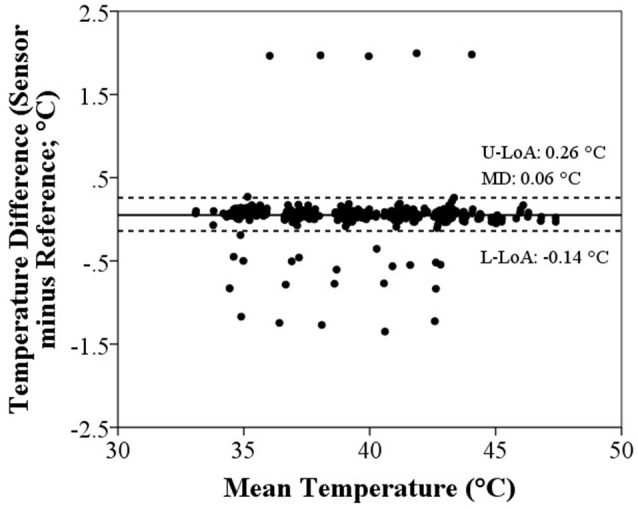
Bland-Altman plot of the agreement between ingestible sensor and reference temperatures. Solid and dashed lines represent the mean difference (MD) and limits agreement (LoA; upper–U, and lower–L), respectively.